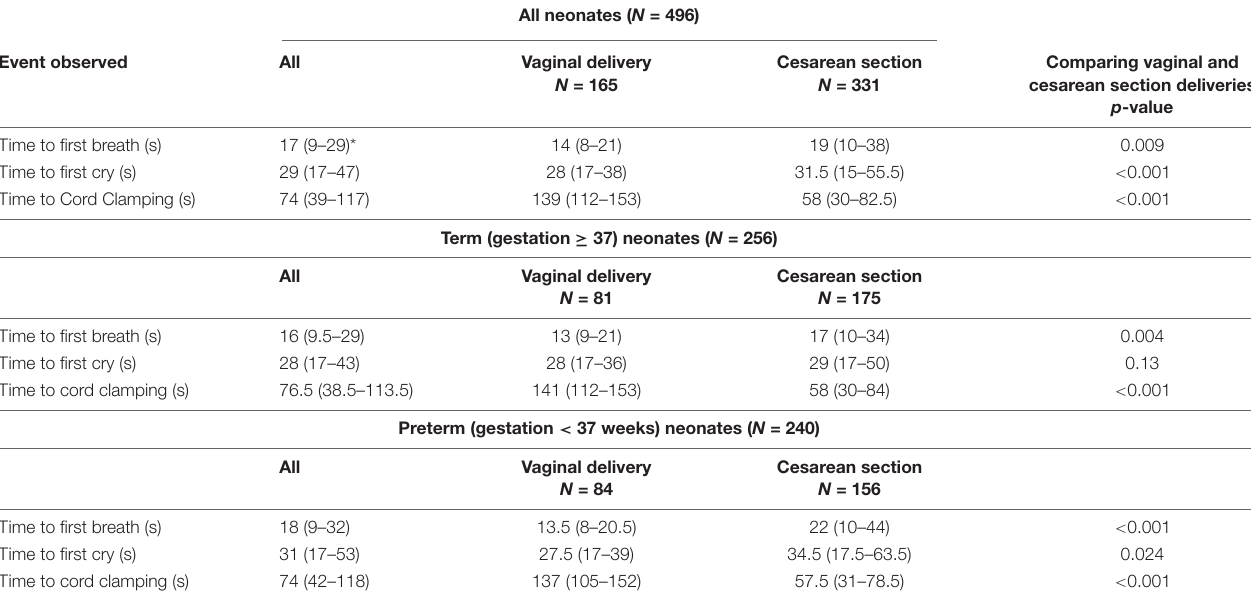
TABLE 2 | Time to first breath, first cry, and clamping of the cord from birth according to the mode of delivery in term and preterm